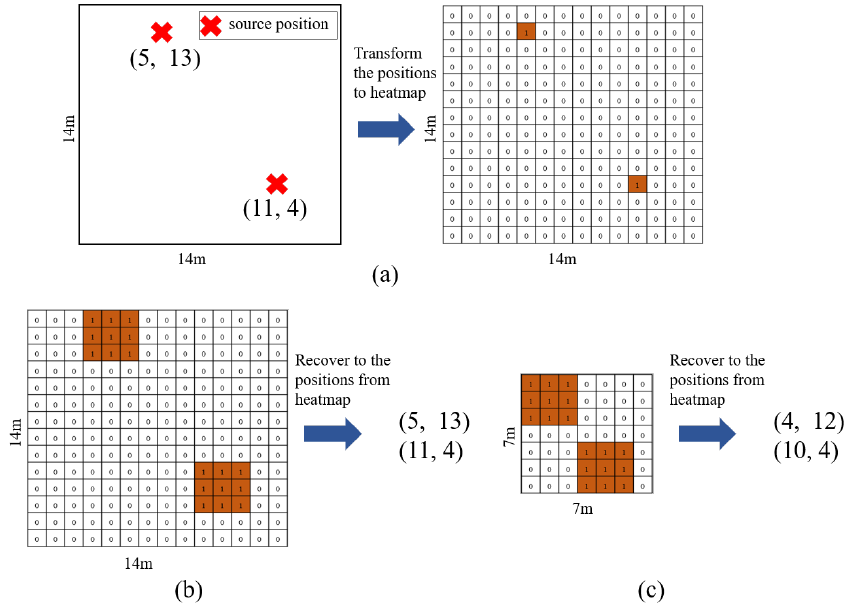
Figure 3. ( a ) Heatmap with ideal delta functions; ( b ) heatmap with a region of radius R without quantization error; ( c ) heatmap with a region of radius R with quantization